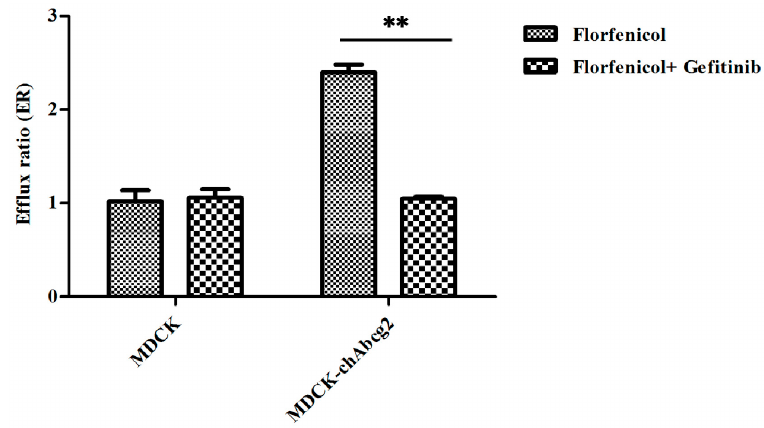
Figure 1. The efflux ratio (ER) of florfenicol across different cell monolayers with or without inhibitor. Data are represented as mean ± SD of three independent experiments. ** p < 0.01.